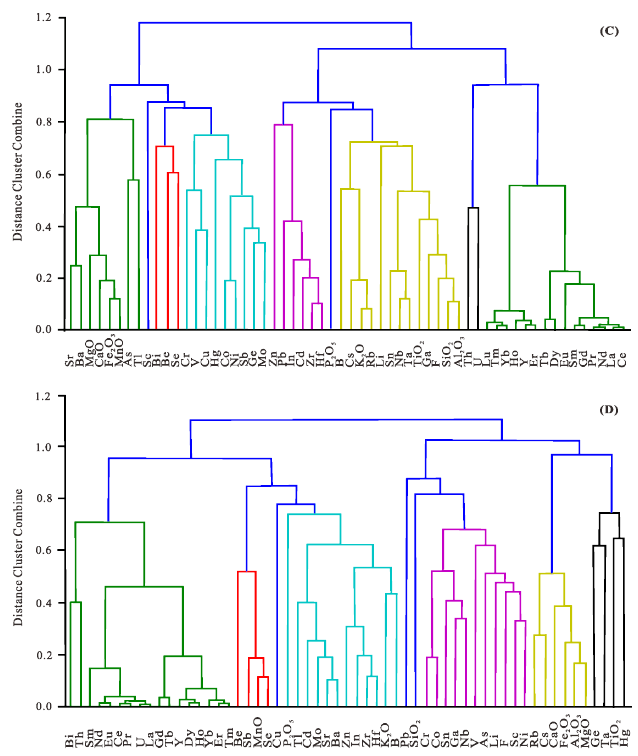
Figure 1. Cluster analysis for coal element data from the Datanhao mine. ( A ) Improved alr on coal and ash basis; ( B ) Geboy’s approach on coal and ash basis; ( C ) clr on coal and ash basis; ( D ) ilr on coal and ash basis.